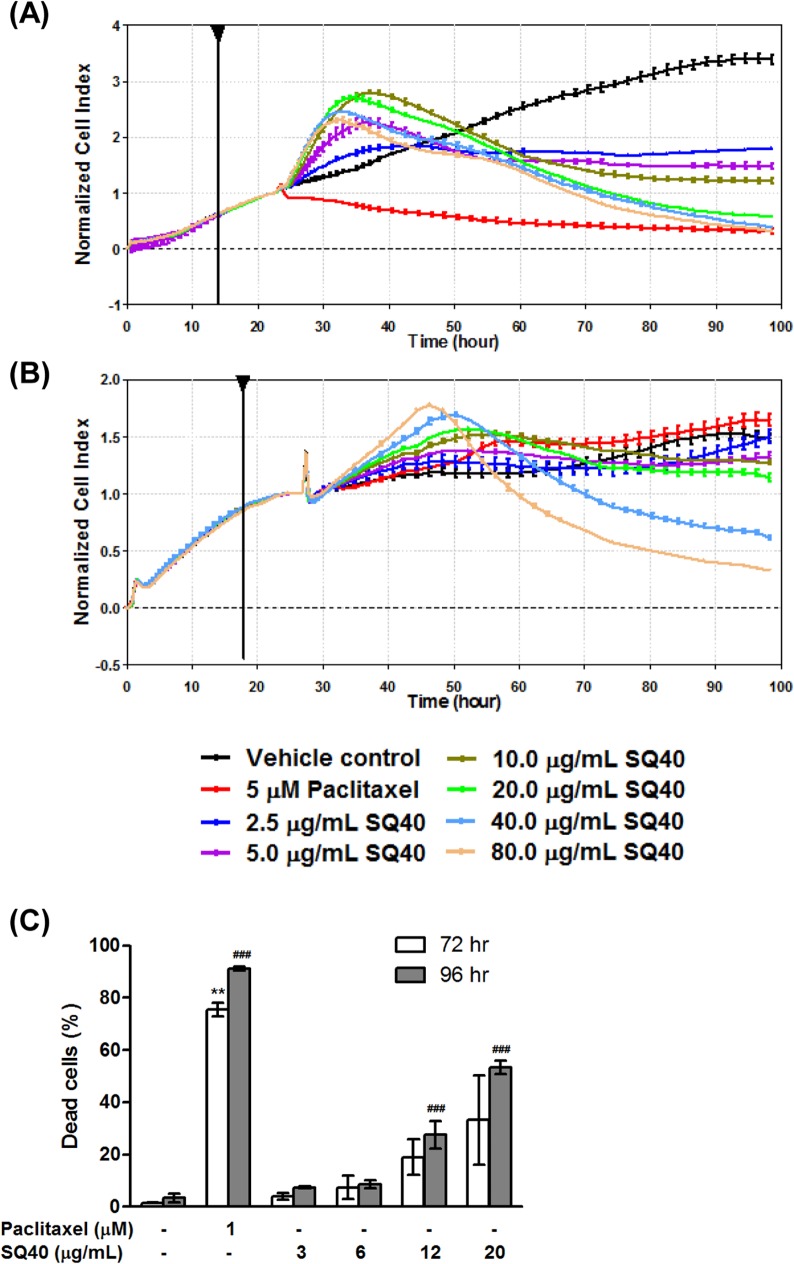
Growth profile of LNCaP and RWPE-1 cells upon treatment with SQ40.The growth kinetics of (A) LNCaP and (B) RWPE-1 cells were examined real-time using RTCA. The impedance values were recorded in real-time and were expressed as the Cell Index (CI). Cells treated with growth media alone were referred as vehicle control while 5 μM paclitaxel-treated cells were referred as positive control. (C) SQ40-treated LNCaP cells were stained with 0.4% trypan blue solutions in a ratio of 1:1 after 72 and 96 hours of treatment respectively. Cells treated with growth media alone were referred as vehicle control while 1 μM paclitaxel-treated cells were referred as positive control. Data were expressed as means ± SEM of three independent experiments. ** indicates p<0.01 versus 72-hour treated vehicle control. ## indicates p<0.01; ###, p<0.001 versus 96-hour treated vehicle control.